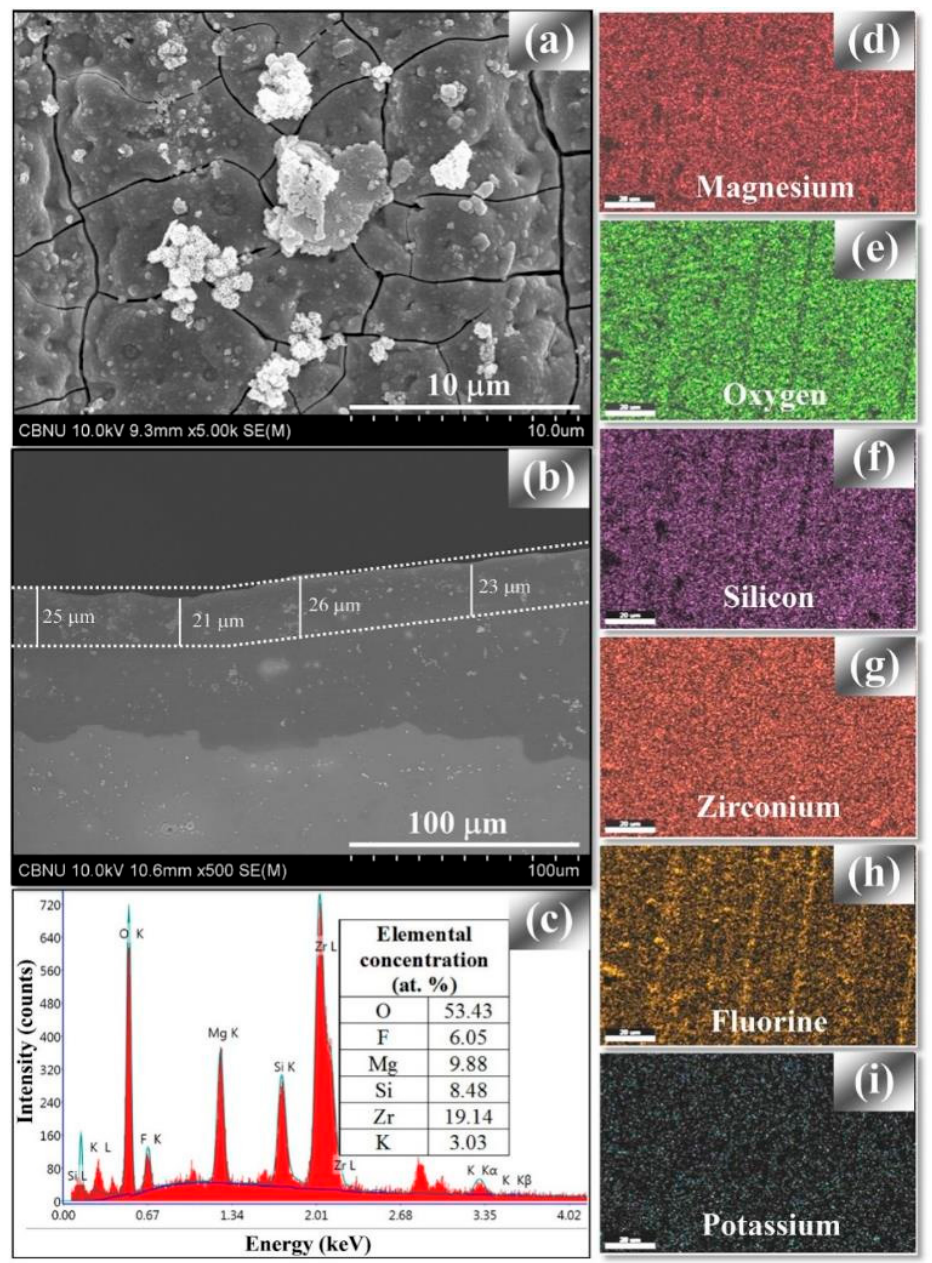
Figure 13. ( a ) Surface morphology; ( b ) cross sectional morphology; ( c ) EDS spectrum, along with the chemical composition. ( d – i ) X-ray elemental mapping of the MAO coating deposited on Mg in